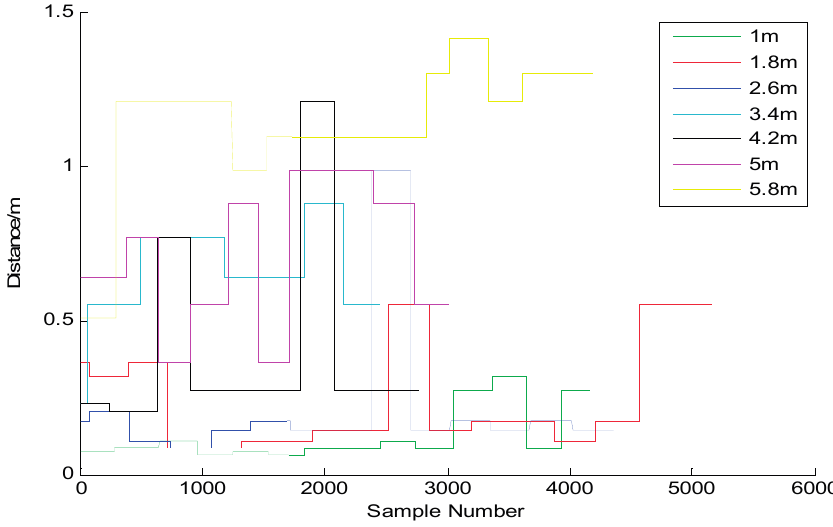
Figure 2. Changes in the pseudo-distance between the beacons every 0.8